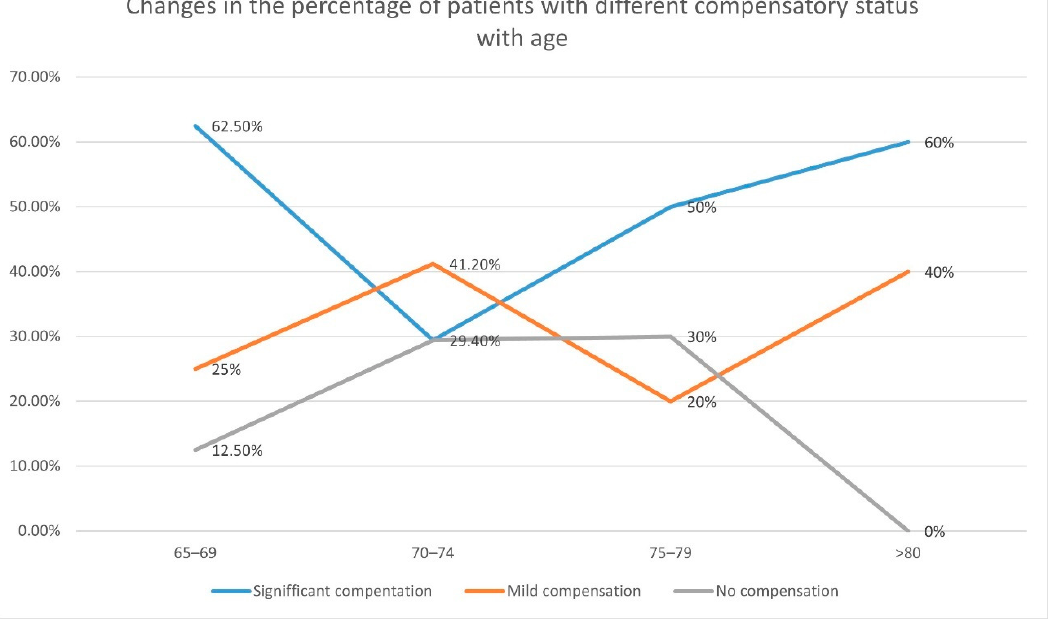
Figure 1. Tendencies in CBF changes in different age group. The percentage of patients with significant flow compensation tended to rise with increasing age. The percentage of patients with mild compensation did not change significantly, showing only slight fluctuations from 20% to 41.2%. The percentage of patients without compensation tended to be least prevalent group. These patients were not observed in the oldest age group. Table 3. Detailed data concerning the flow compensation in different age groups.